Question: Sum up the contents of this chart in one sentence.
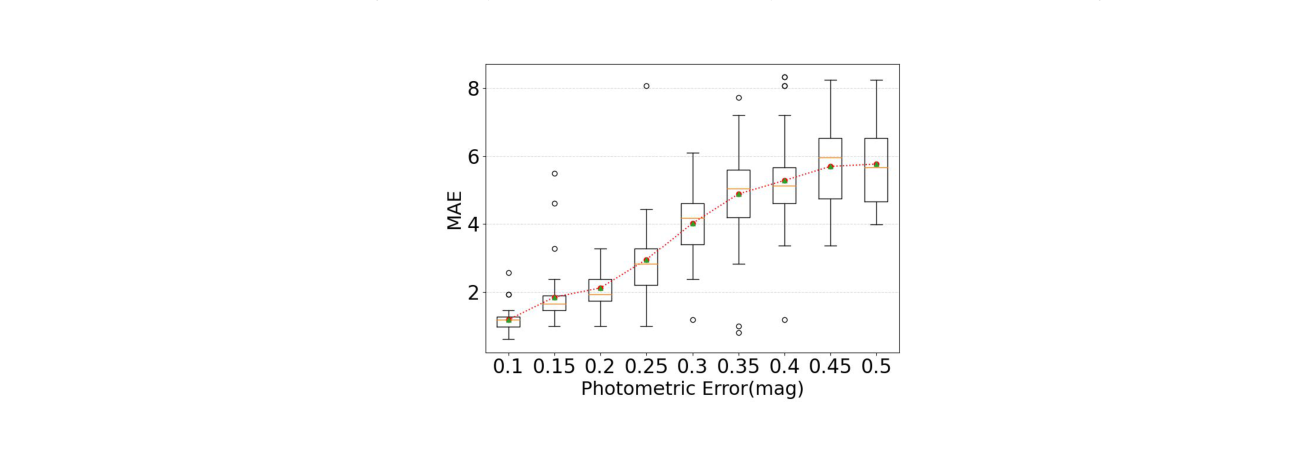
Answer: The figure shows the relationship between the MAE and the photometric errors. The black straight line stands for mean values and the red dotted line stands for the median values of all images.